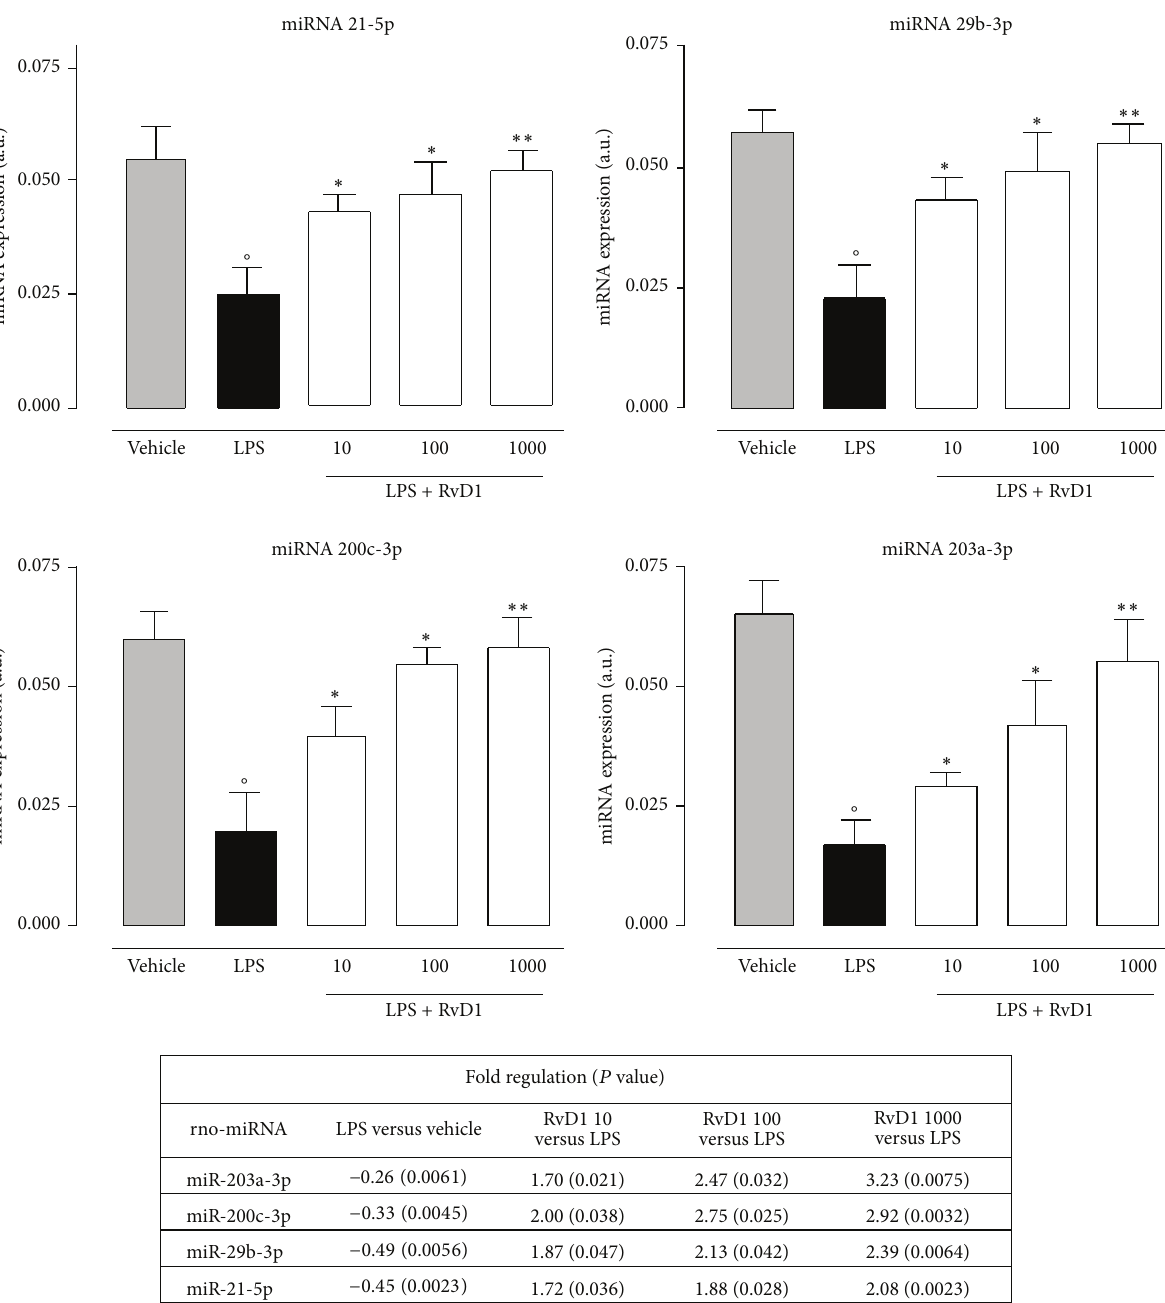
Figure 4: Change in miRNAs expression in LPS and in LPS+RVD1 treated rats. 4 miRNAs were significantly upregulated in LPS+RvD1 (10- 100-1000ng/kg) compared to LPS-rats. Arbitrary units are 2 − Dct values obtained from RT-qPCR analysis and without any multiplying factor. Values are mean ± SEM of 𝑛 = 6 observations for each groups. ∘ 𝑃 < 0.01 versus vehicle-group; ∗ 𝑃 < 0.05 and ∗∗ 𝑃 < 0.01 versus LPS-treated group. The table shows the miRNAs fold regulation and relative 𝑃